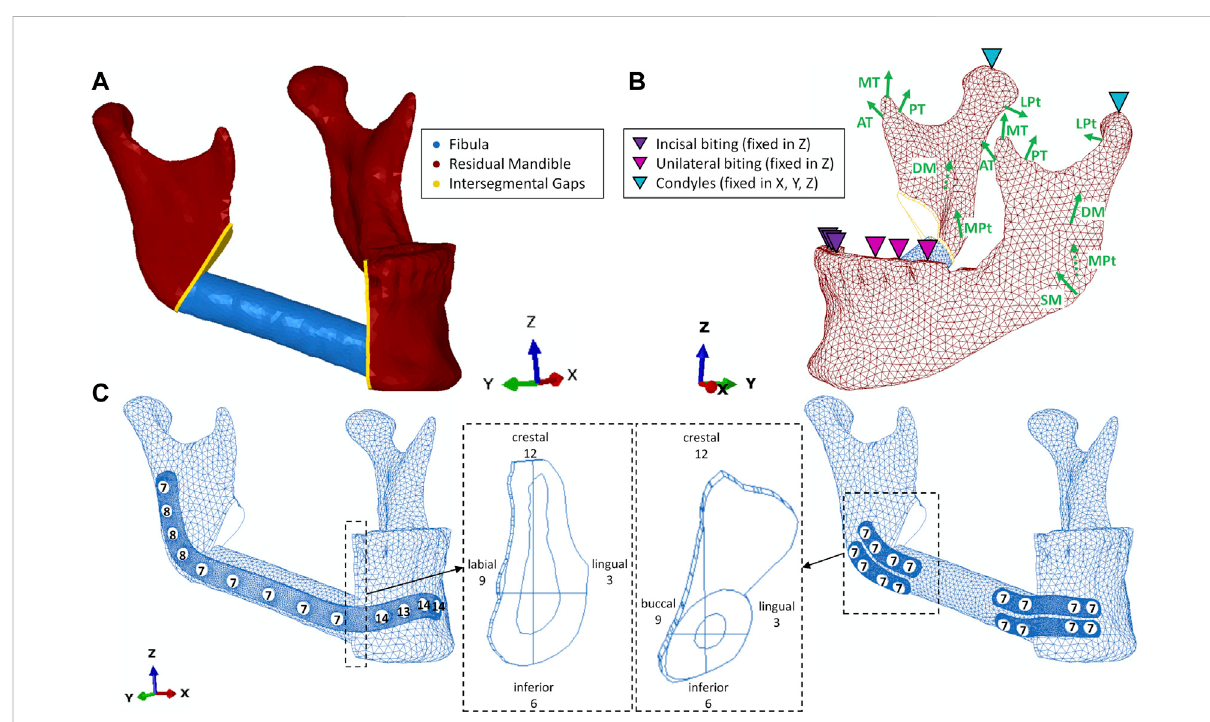
FIGURE 1 (A) geometry without fi xation; (B) loading and boundary conditions including muscles super fi cial- (SM) and deep (DM) masseter, medial- (MPt) and lateral (LPt) pterygoid, anterior- (AT), medial- (MT) and posterior (PT) temporalis; (C) reconstruction plate and miniplate with screws and screw lengths (in mm), intersegmental gaps with anatomical and given clock